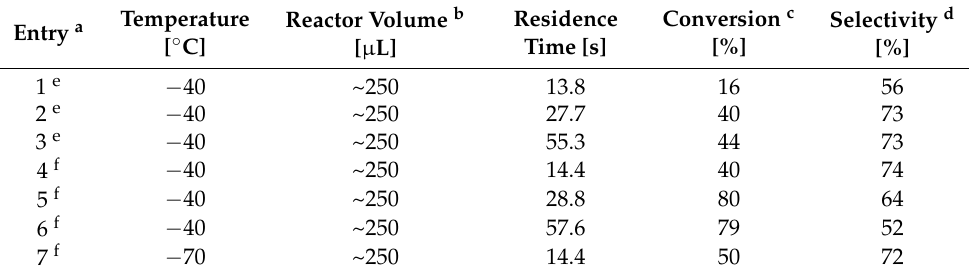
Table 2. Reduction using DIBAL-H in packed-bed reactors (Reactor B).